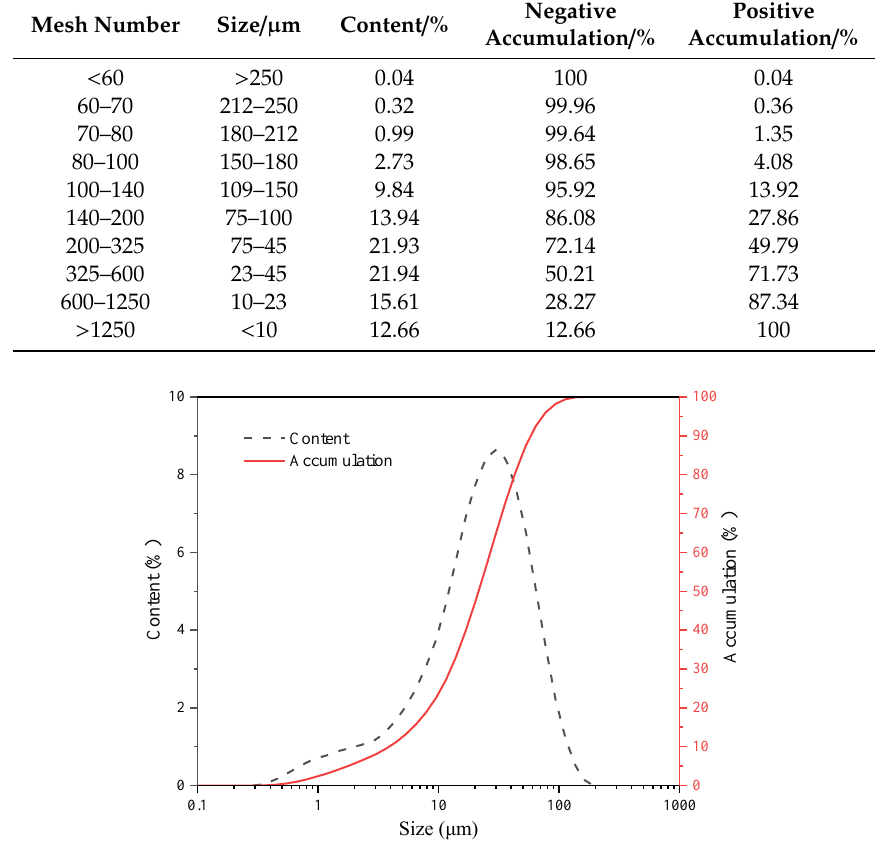
Figure 7. Particle size distribution of test material.